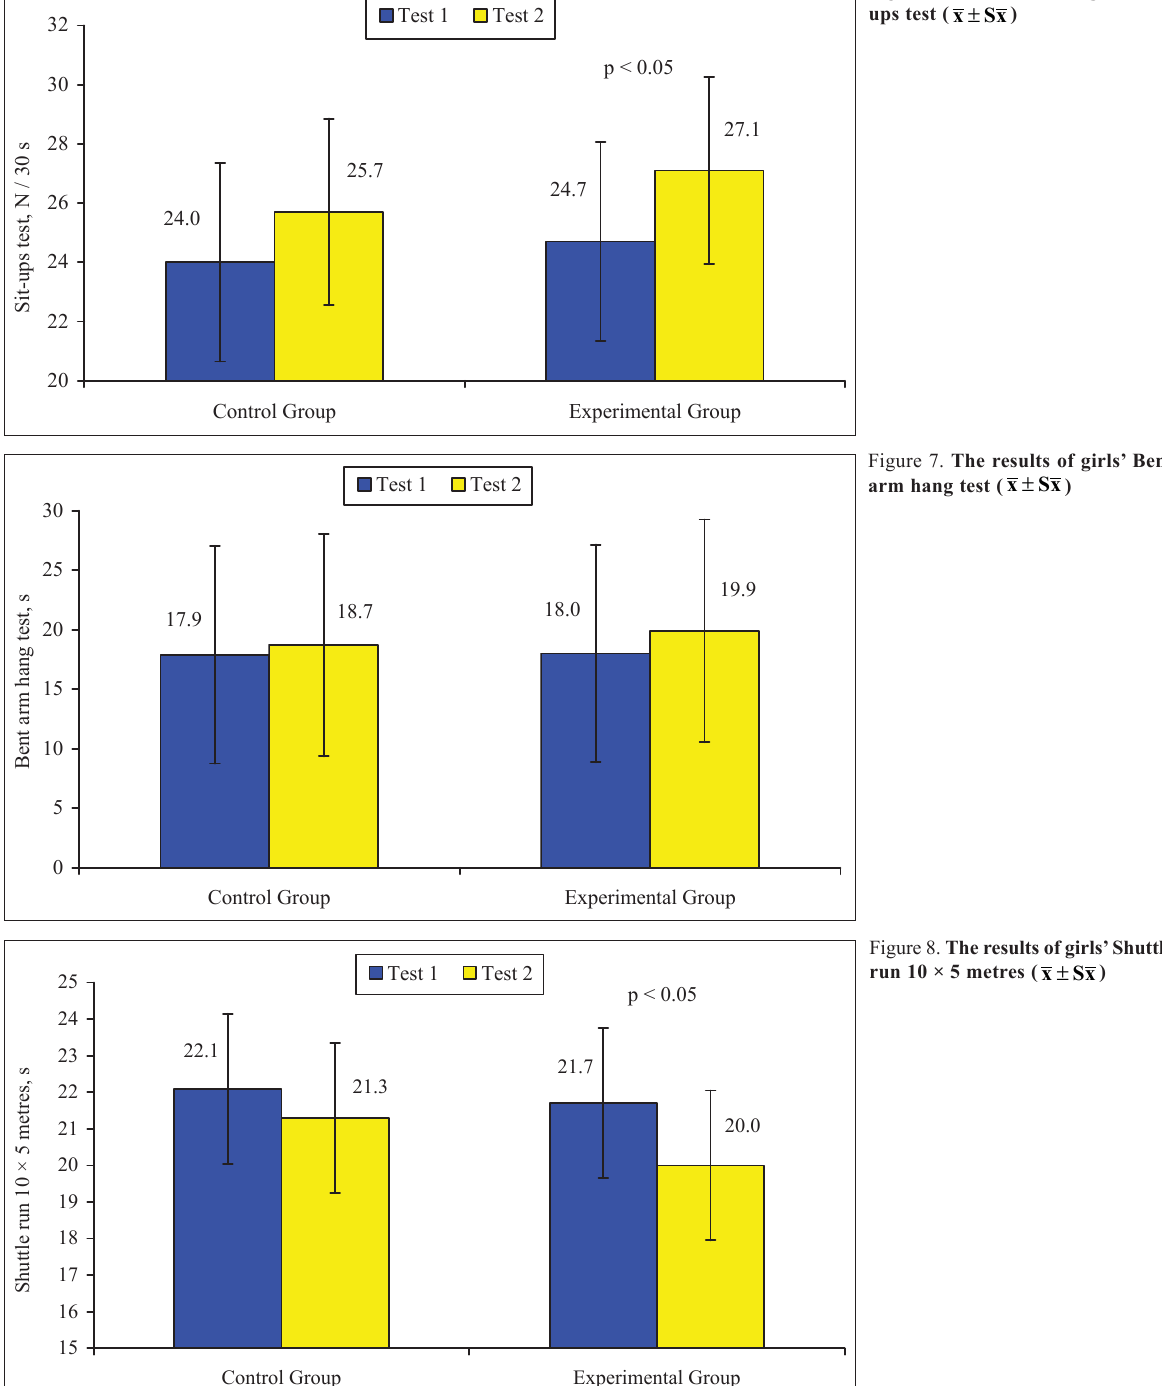
Figure 6. The results of girls’ Sit- ups test ( xSx ±